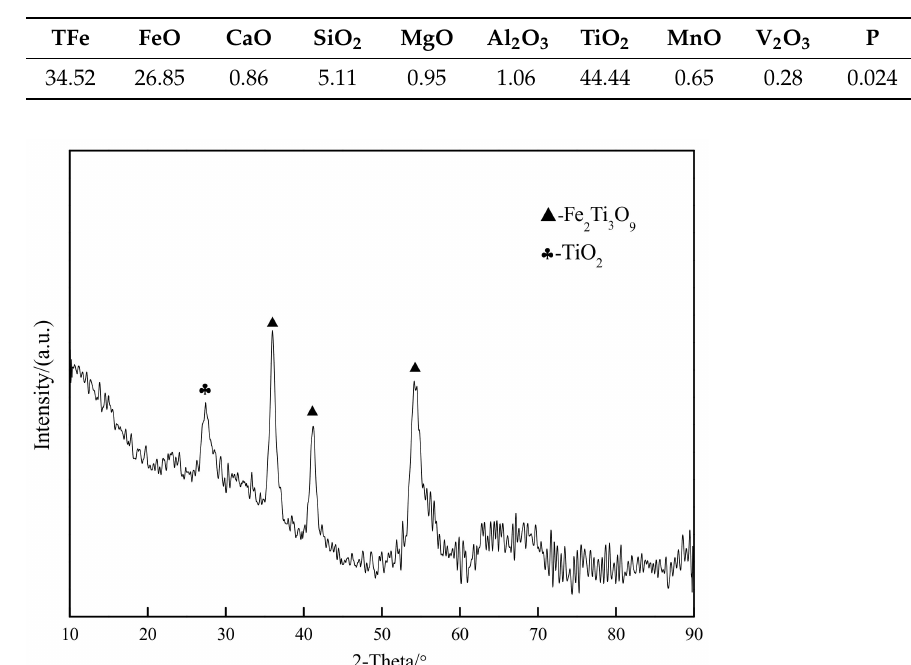
Table 1. Chemical composition of ilmenite (mass %).